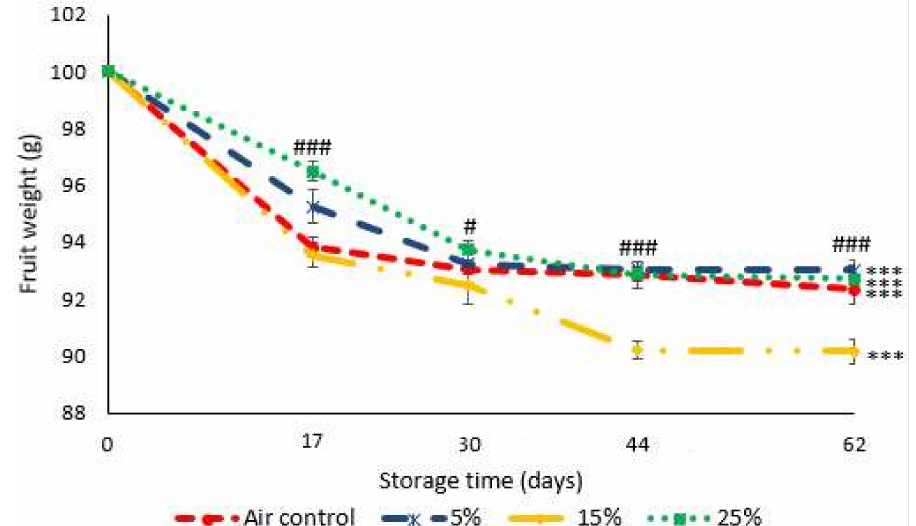
Figure 1. Blueberry ‘Liberty’ fruit weight loss under the air control and controlled atmospheres (5% CO 2 , 5% O 2 , 90% N 2 (5%); 15% CO 2 , 5% O 2 , 80% N 2 (15%); and 25% CO 2 , 5% O 2 , 70% N 2 (25%)) for different storage times. ***, p < 0.001 (versus storage = 0, within each storage condition). #, p < 0.05; ###, p < 0.001 (versus air storage, for each storage